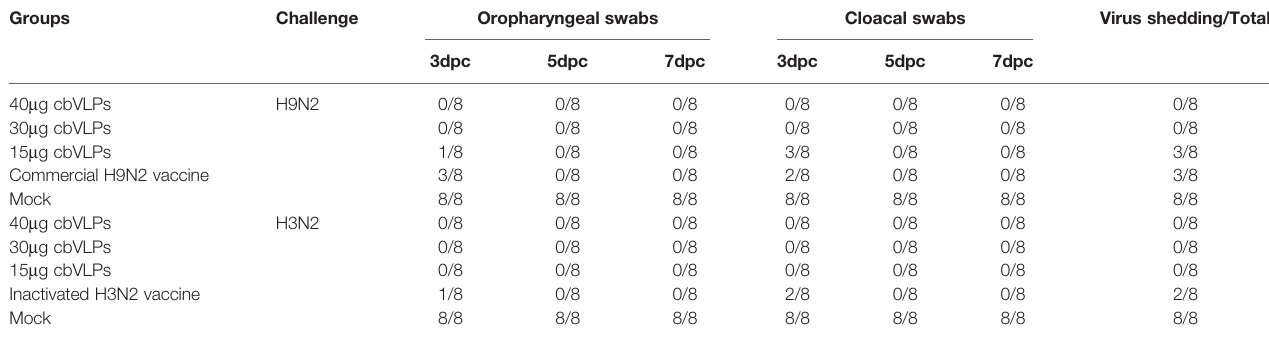
TABLE 2 | In vitro detection of virus shedding in the oropharyngeal and cloacal swabs from those immunized chickens on 3, 5, and 7 days post challenge (dpc) with H9N2 or H3N2 AIV strains. Groups